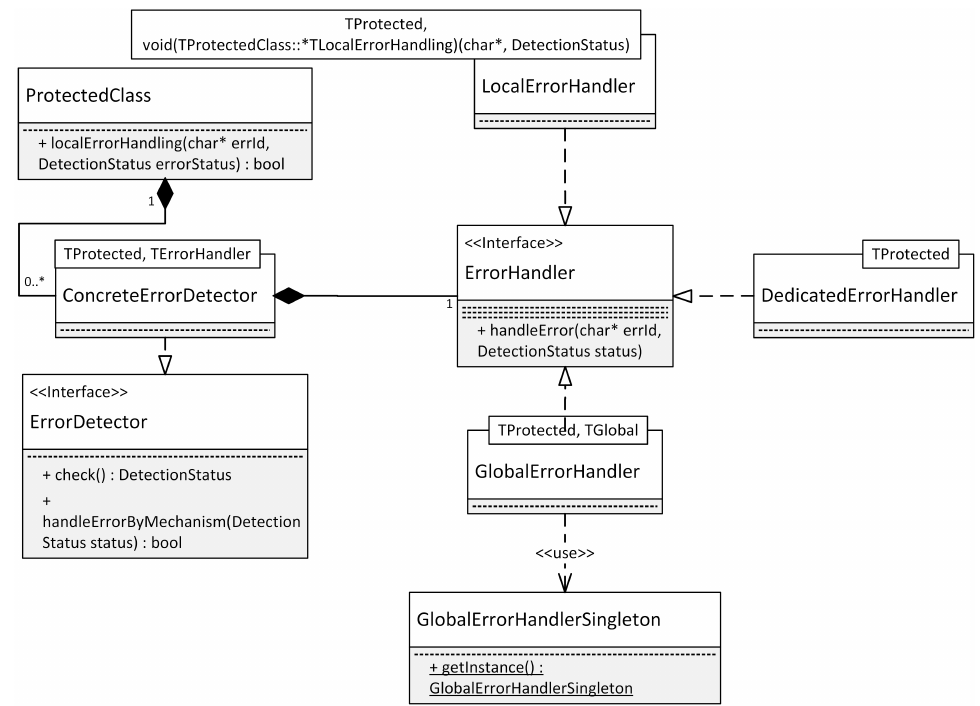
Figure 11. Integration of software-implemented safety mechanisms in an existing software architec- ture (UML 2.5 class diagram